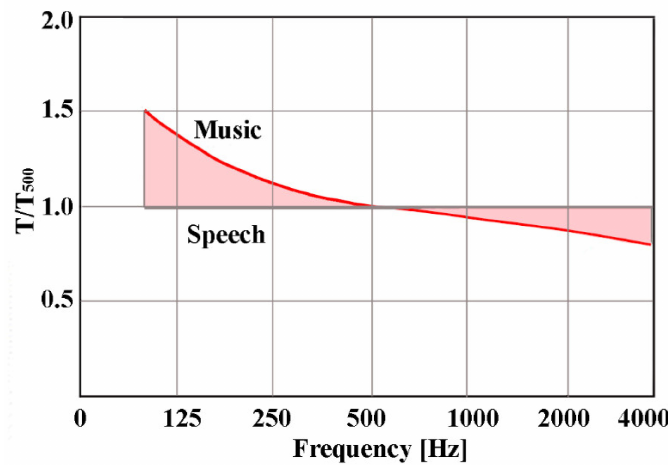
Figure 7. Optimal reverberation time-frequency limits considering the ratio between the reverberation time at the given frequency compared to that at 500 Hz [42].